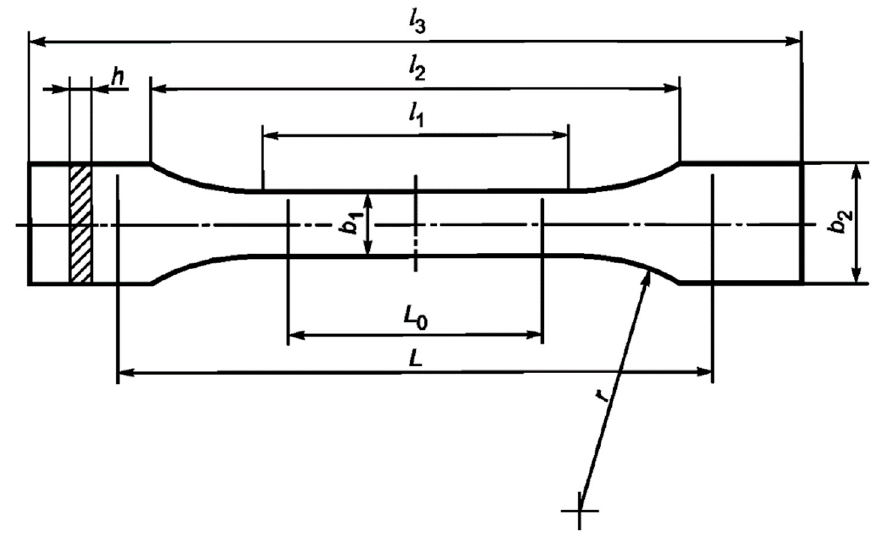
Figure 2. Tensile test sample. Dimensions, in mm: l1 = 80 ± 2, l2 = 109.3 ± 3.2, l3 = 170, L0 = 75 ± 0.5, L = 115 ± 1, b1 = 10 ± 0.2, b2 = 20 ± 0.2, h = 4 ± 0.2, r = 24 ± 1.